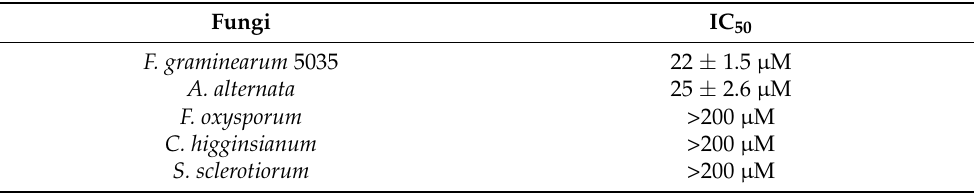
Table 1. Antifungal analysis of TaARL6IP4 against representative fungi.